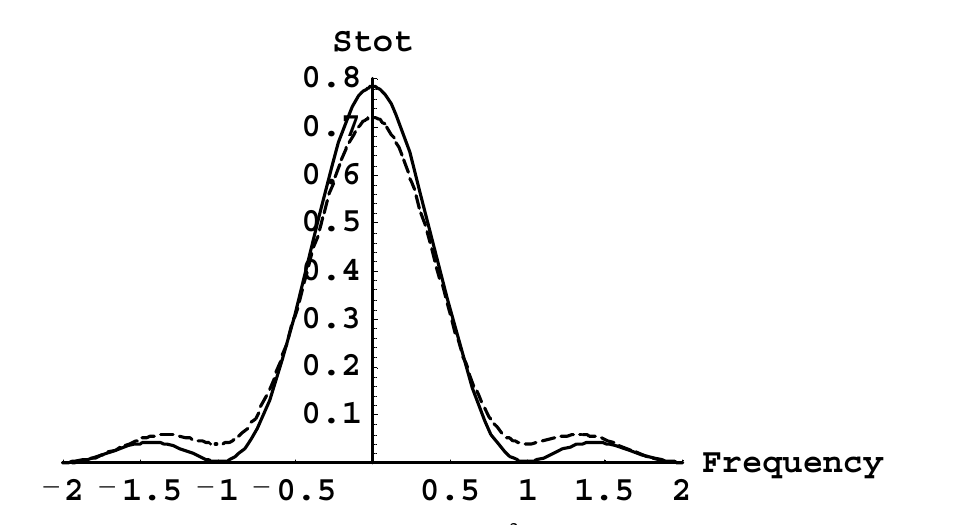
Figure 27. Total profile of all “shifted” components at q 2 = 1/5 and two values of ε : ε = 0.9 (solid line) and ε = 0 (dashed line). The frequencies are in units of the Kepler frequency Ω of the outer electron ( given by Equation (12.3)) [150].